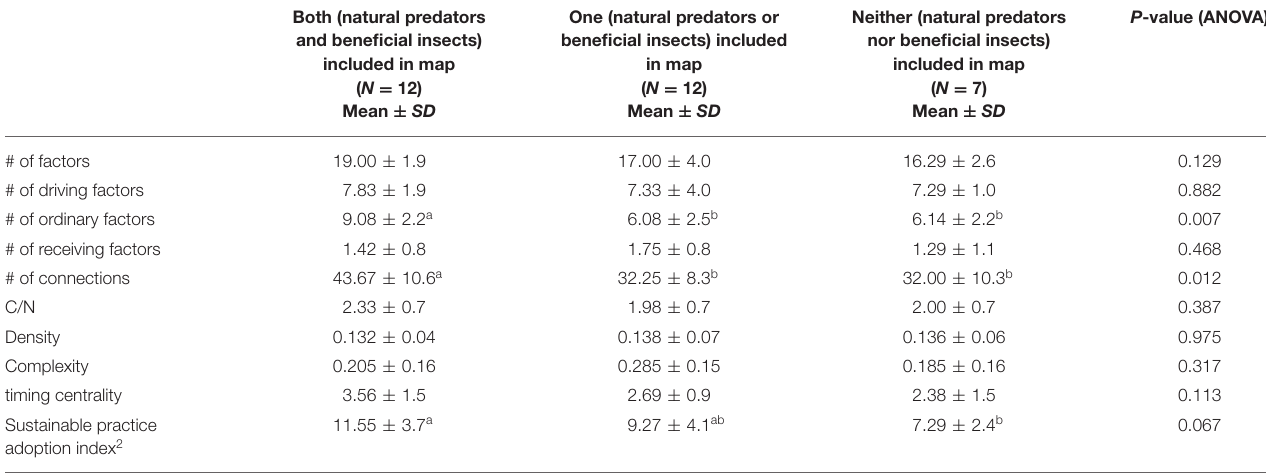
TABLE 2 | Mean differences for mental model metrics and adoption of conservation practices index by inclusion/exclusion of biological control factors in Fuzzy Cognitive Maps 1 . Both (natural predators and beneficial insects) included in map ( N =